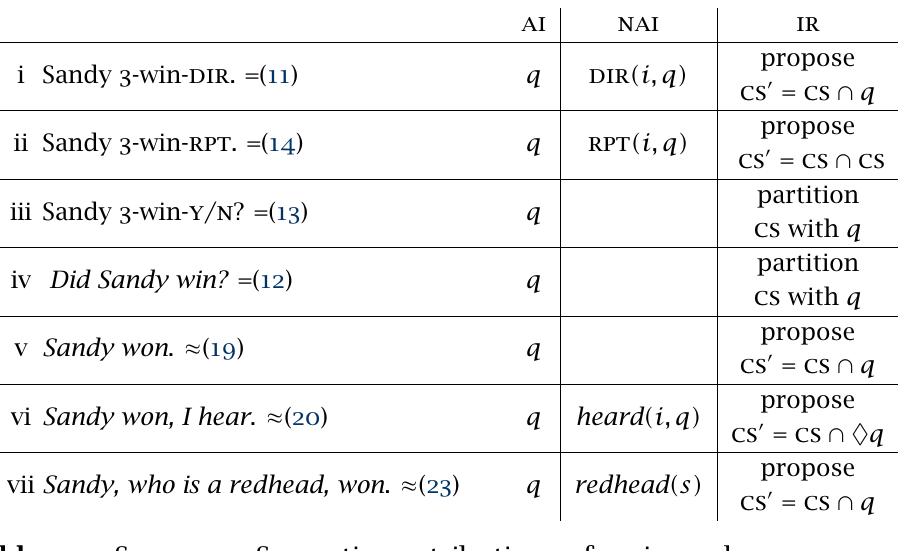
Summary: Semantic contributions of various